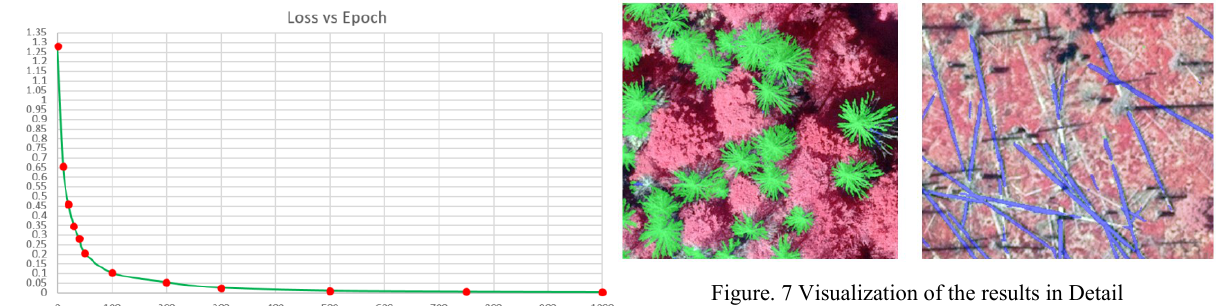
Figure. 7 Visualization of the results in Detail